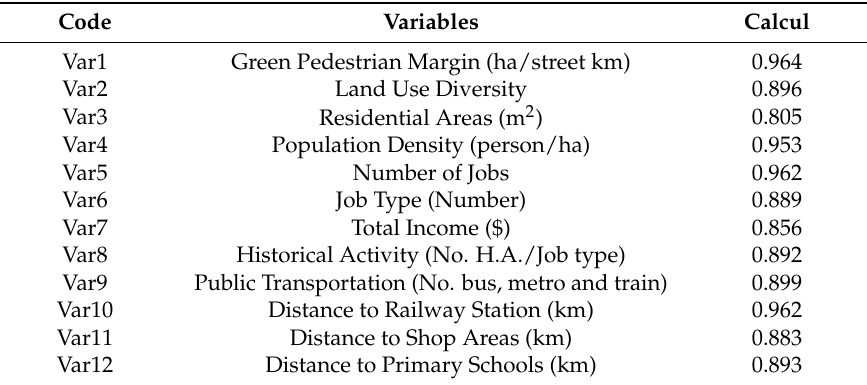
Table 4. Selected list after factor analysis of independent